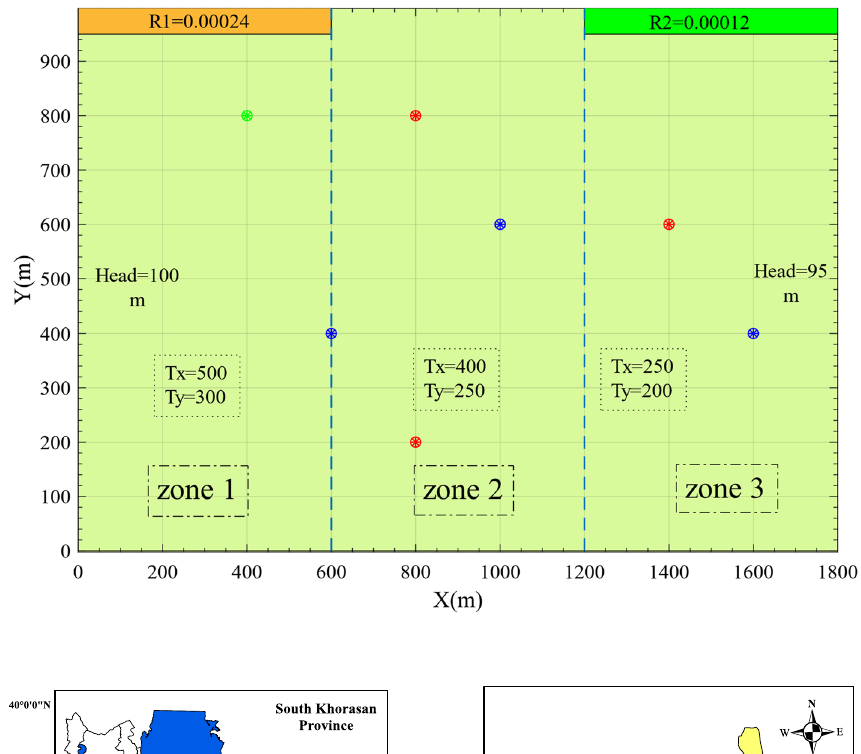
Fig. 3 Location of Birjand unconfined aquifer in